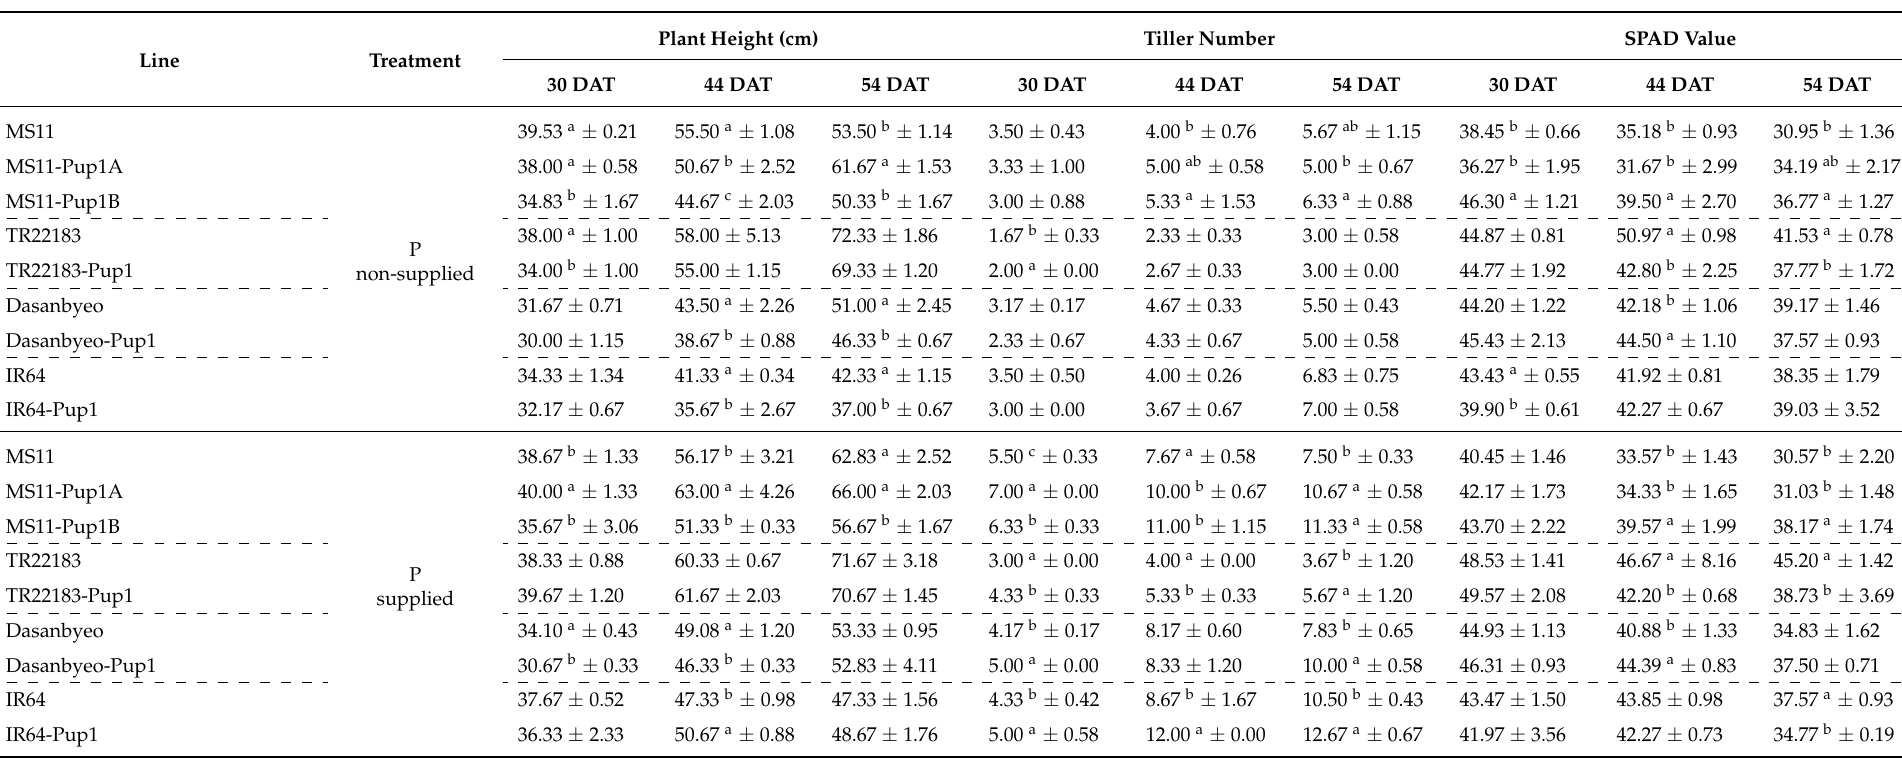
Table 2. Vegetative stage response of Temperate-Pup1 introgression lines and IR64-Pup1 ( indica control) grown in 2022 at Hwaseong low-phosphorus experimental field. Means with the same letters within a genetic background, treatment, and timepoint are not significantly different using Duncan’s Multiple Range Test (DMRT) at p = 0.05. Values are means ± Standard error of the mean